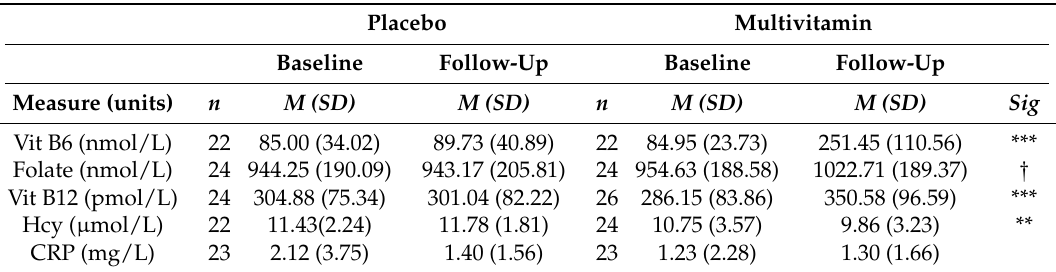
Table 3. Blood levels of B-vitamins, homocysteine and C-reactive protein for both treatment groups before and after four-weeks of